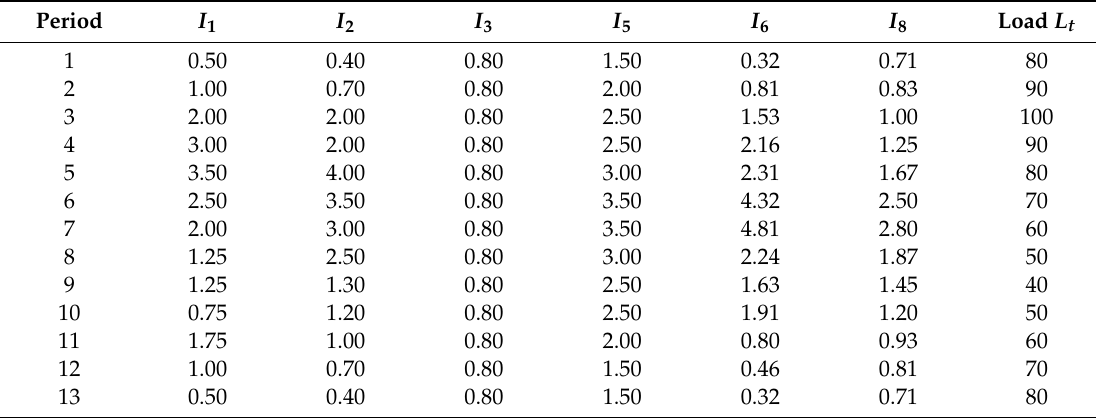
Table 6. Local inflow of the mature multi-reservoir